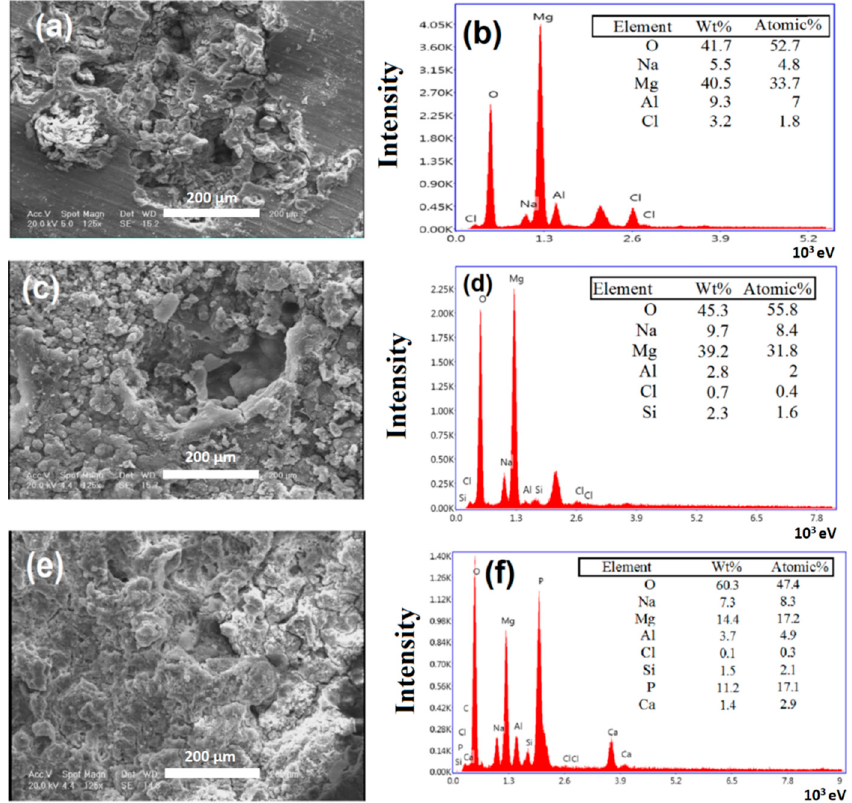
Figure 2. SEM images of ( a ) AZ91, ( c ) MAO, ( e ) MAO / P / 5Ba, and EDS spectra of ( b ) AZ91, ( d ) MAO, and ( f ) MAO / P / 5B, after corrosion test in SBF for 30 min.